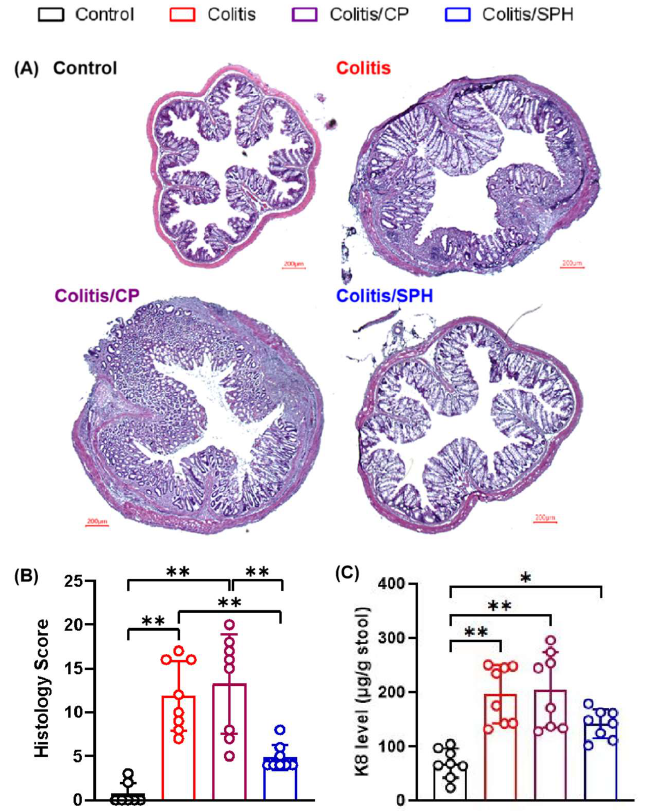
Figure 3. SPH reduces tissue injury of the colon in the TNBS-induced colitis model. ( A ) Histology images with H&E stain (×200). ( B ) Histology grading on gastrointestinal injury. ( C ) Keratin (K8) level in stool by ELISA. The numbers of mice in the four groups were 7, 8, 8, and 8, respectively. Data are presented as mean ± SD and analyzed by one-way ANOVA test. **: p < 0.01, *: p < 0.05. In addition to the tissue damage observed on histopathology, we also measured sig- nificant changes in the intestinal epithelial injury biomarker K8 in stool samples. While the level of K8 was increased in the Colitis/SPH group ( p < 0.05) compared to the Control group, the increase was significantly attenuated compared to the Colitis and Colitis/CP groups ( p < 0.01) (Figure 3C). Taken together, these results suggests that SPH treatment significantly diminishes colonic epithelial injury as determined by quantitative K8 shed in stool samples.